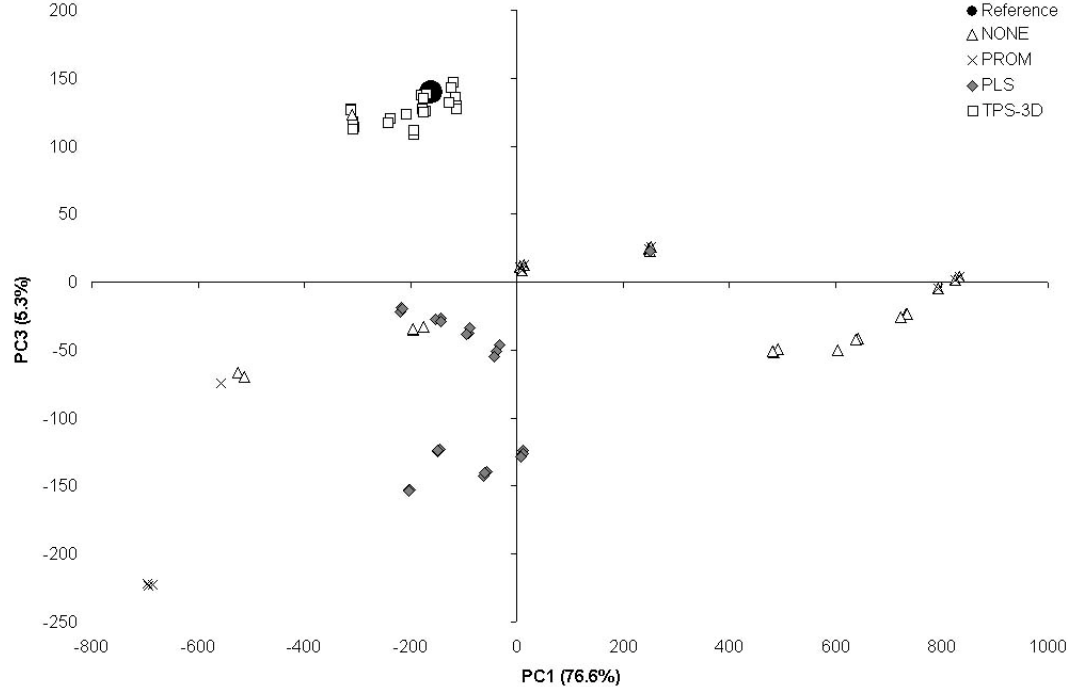
Figure 3. Scatter plot of axis 1 and 3 scores of the PCA based on the scores obtained from the 140- and 7-patches calibrated from the ColorChecker